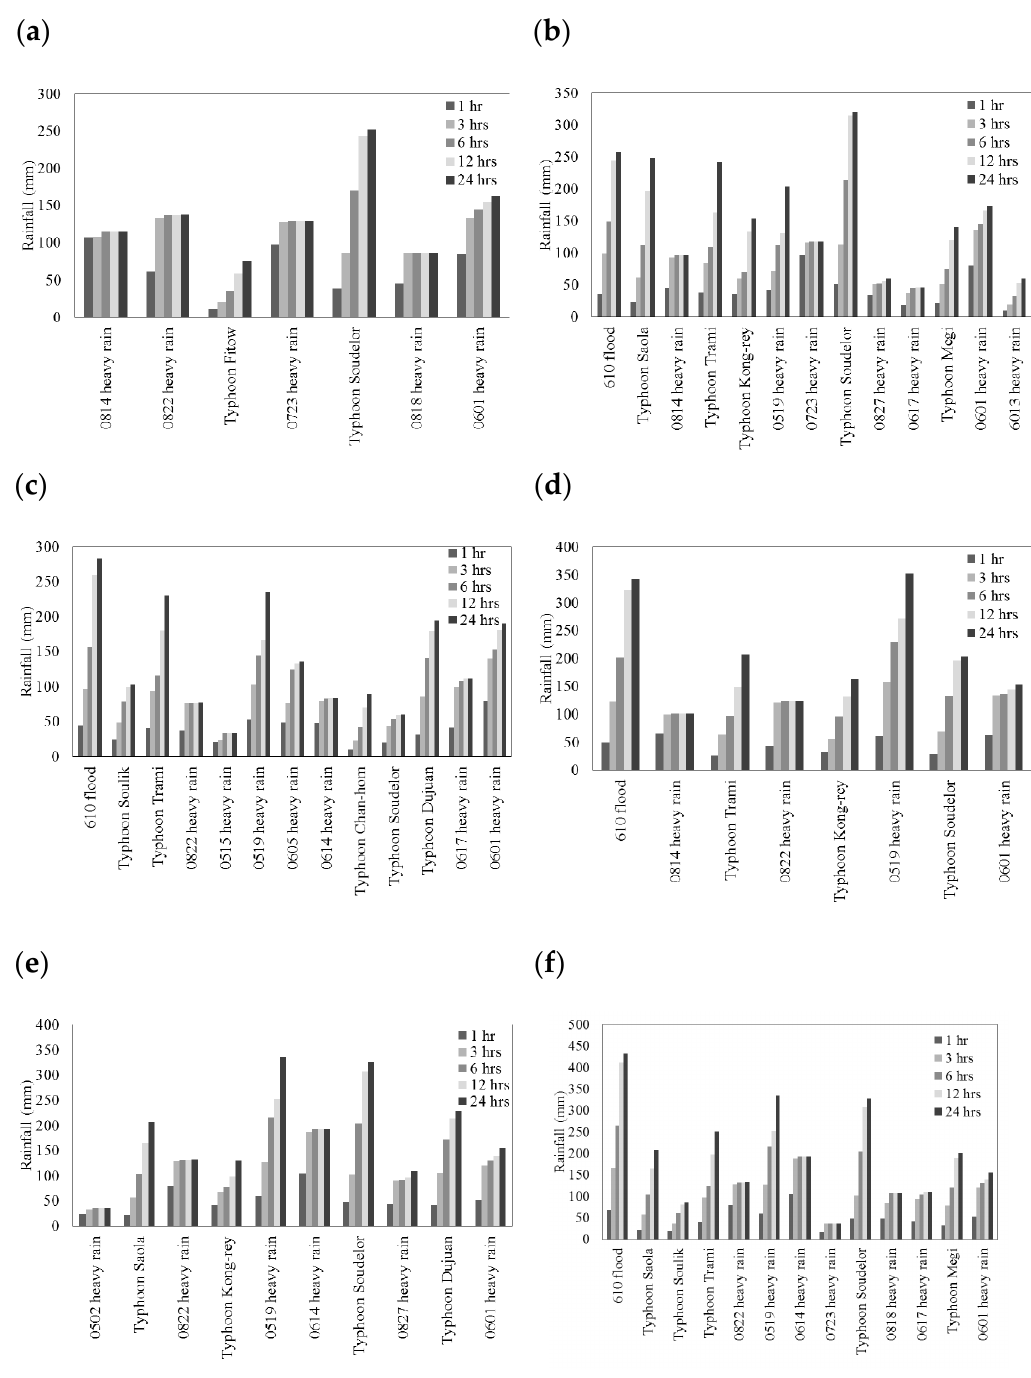
Figure 3. The maximum cumulative rainfalls for 1-, 3-, 6-, 12- and 24-h durations in six districts: ( a ) Datong; ( b ) Zhongshan; ( c ) Songshan; ( d ) Wanhua; ( e ) Zhongzheng; and ( f ) Daan.